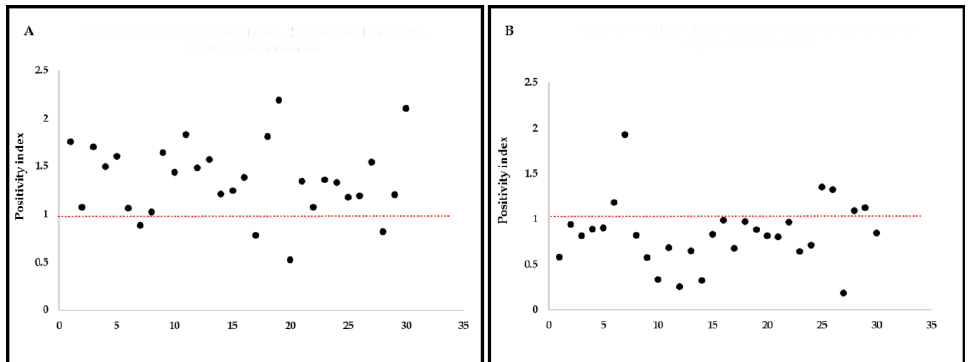
Figure 1. Scatter chart of values according to positivity index for each serum sample in ELISA: ( A ) 30 B. bovis -positive cattle serum samples and ( B ) 30 Babesia sp.-negative samples compared to IFAT; samples were considered positive by ELISA at a positivity index >1 and negative at <1, respectively.